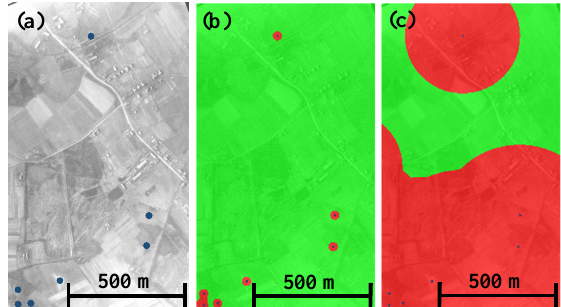
Figure 3: Subset of an aerial wartime image with bomb craters in blue (a) and two impact maps based on different bandwidths ℎ for the Scenarios 1 and 2 of the subset with contaminated and uncontaminated areas shown in red and green, respectively (b, c).